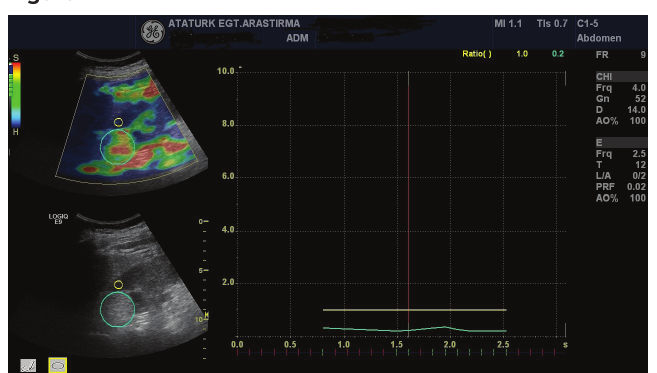
cortex and 36 lesions (98%) were softer. Strain index values were between 0.4-1.1 (mean 0,63) in malignant and between 0.1-0.9 (mean 0,28) in benign lesions. Statistically significant differences were found between mean values of them (p<0.001)